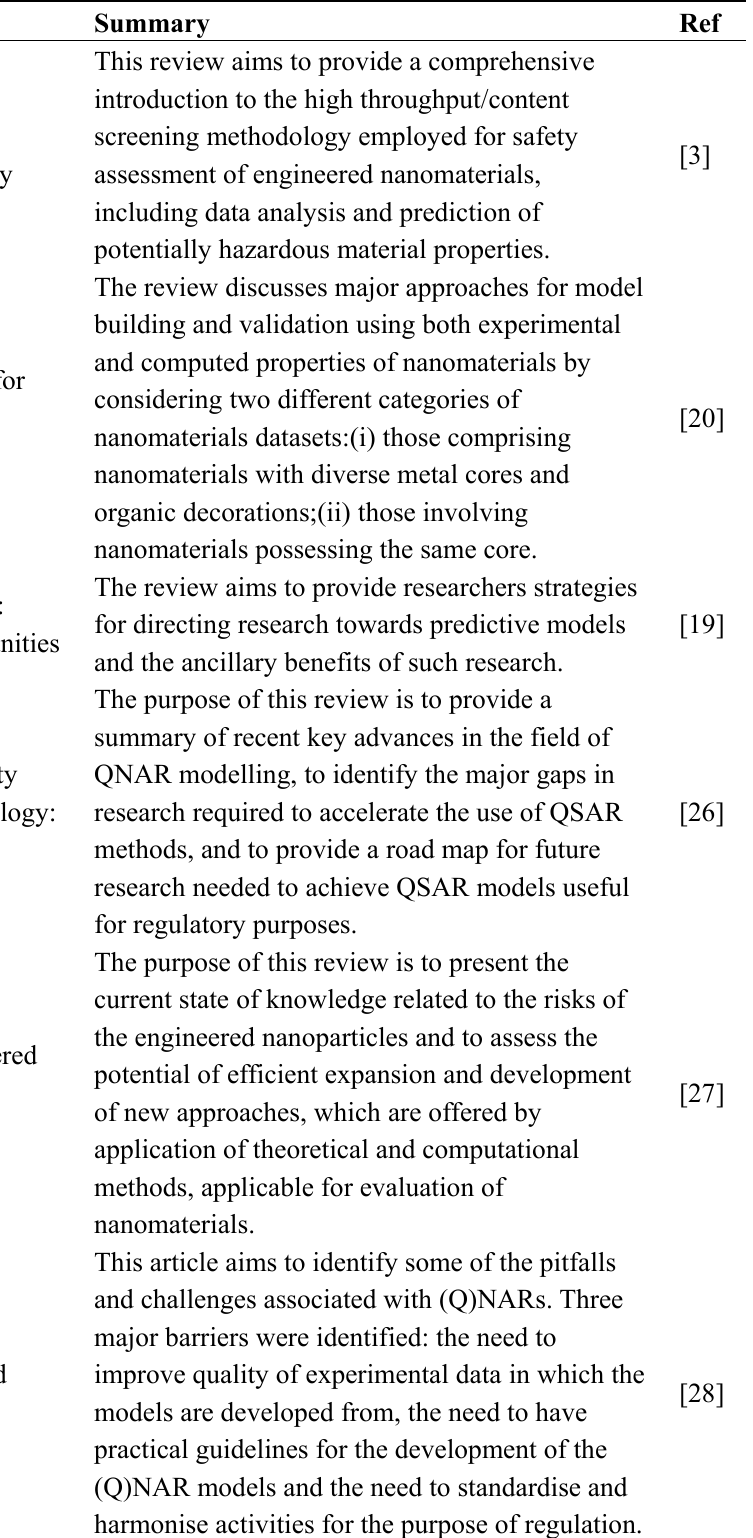
Table 1. Quantitative nanostructure activity relationship (QNAR) reviews in the past five